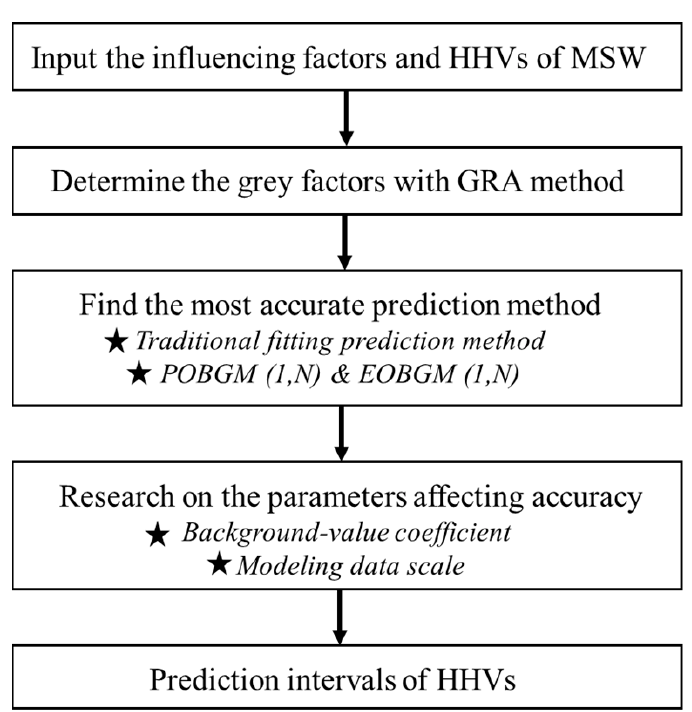
Figure 1. Schematic diagram of the modelling flow.